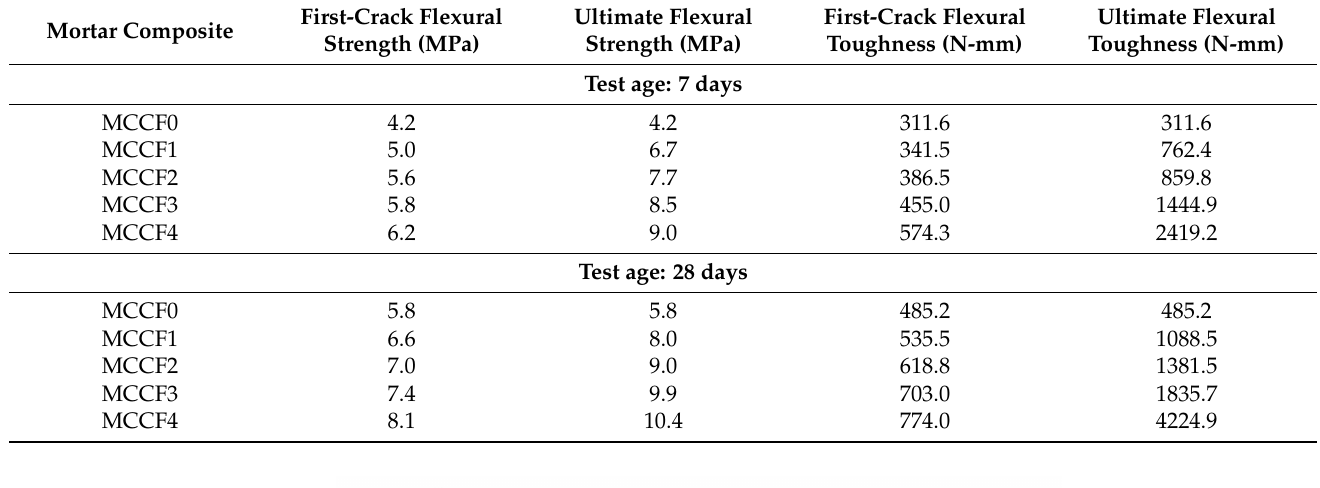
Table 3. Flexural strength and toughness of various mortar composites.